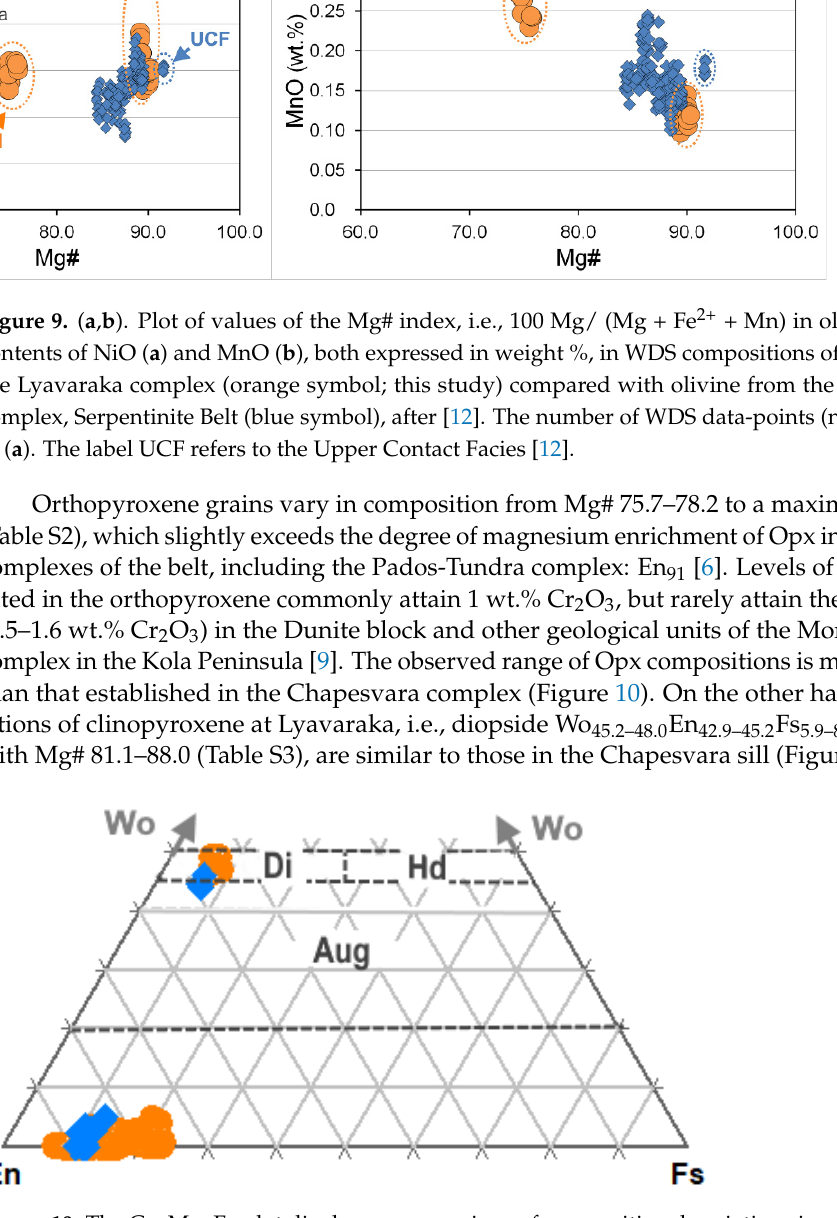
Figure 10. The Ca–Mg–Fe plot displays a comparison of compositional variations in orthorhombic and monoclinic pyroxenes from the Lyavaraka complex (this study) vs. those reported from the Chapesvara sill [12], shown by the orange and blue symbols, respectively. The symbols used are: Wo, wollastonite; En, enstatite; Fs, ferrosilite; Aug, augite; Di, diopside; and Hd, hedenbergite. The nomenclature and mineral names are after [37].